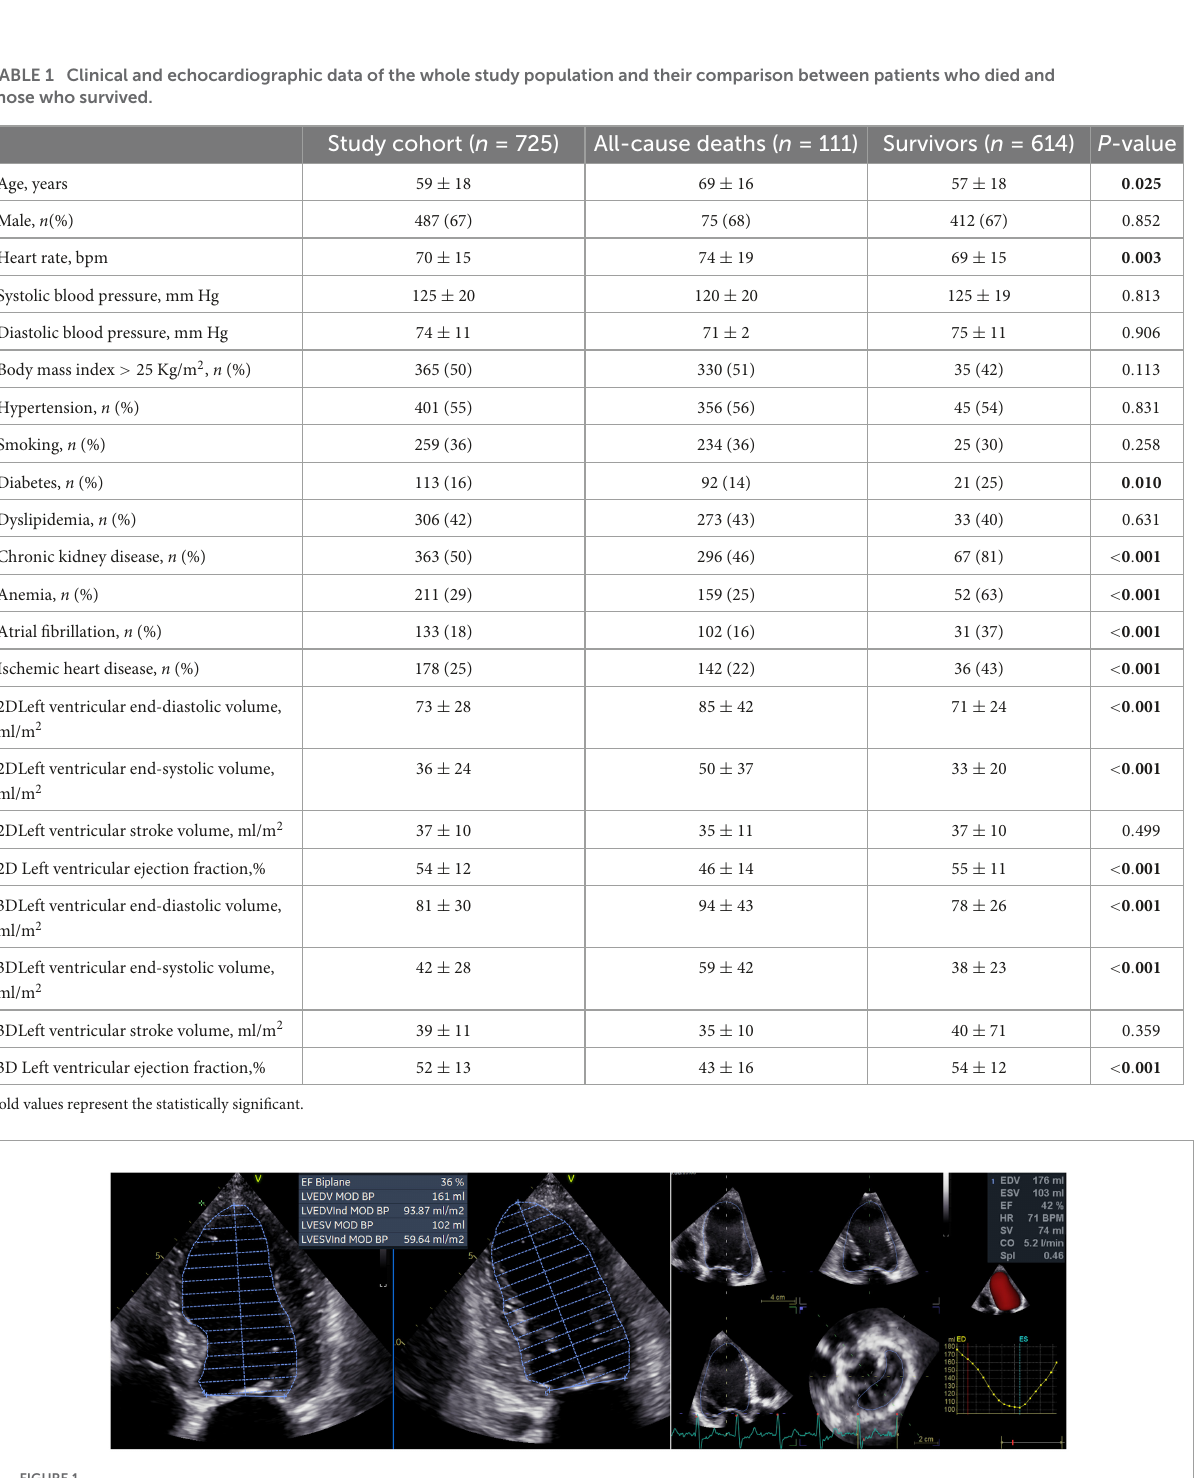
parameters to the baseline CM, resulting in pairs of models for the end-diastolic volume (EDV), the end-systolic volume (ESV), and EF. The proportional hazards assumption for the